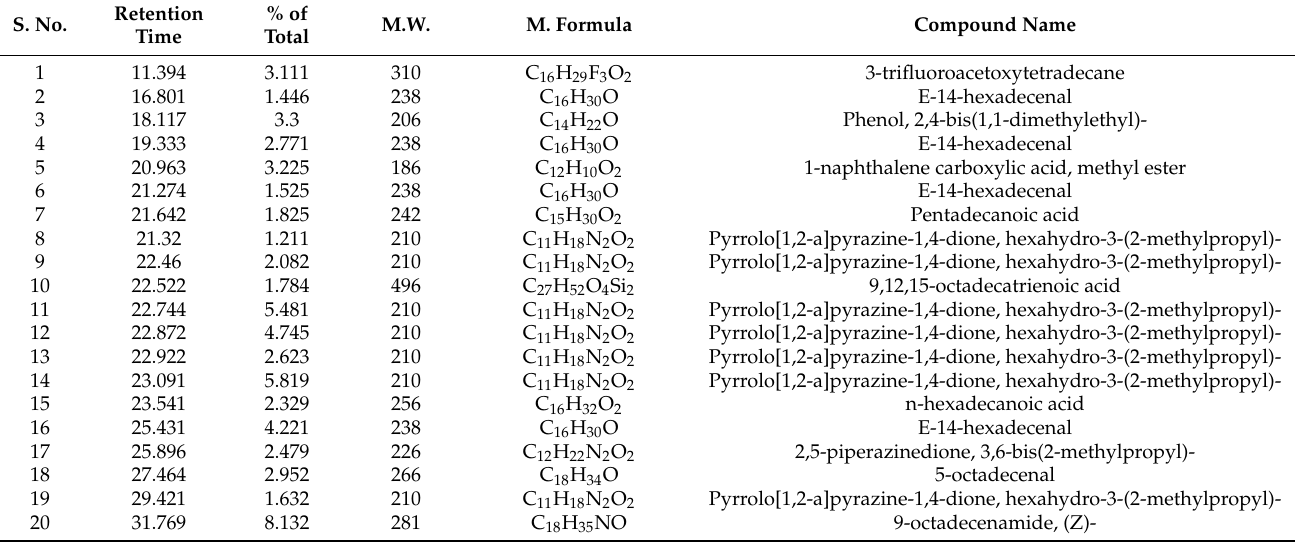
Table 1. GC-MS analysis for methanolic fungal